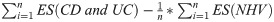
Inflammatory bowel disease molecular activity score classification of patient samples.(A) Shown are the scatterplots of the sum of gene set variation (GSVA) enrichment scores (ES) using all 58 upregulated signatures in Fig 2A common for Crohn’s disease (CD) and ulcerative colitis (UC) participant samples (GSE16879) using the following formula: I_MDS score = ∑i=1nES(CDandUC)−1n*∑i=1nES(NHV). Samples have been classified into normal healthy volunteer (NHV), clinical responders at baseline (R BL) or post-treatment (R PT) and clinical non-responders at baseline (NR BL) or post-treatment (NR PT). Pair-wise T-test statistics are listed in S5 Table. (B) and (C) show the I_MDS score outputs identifying clinical responders and non-responders before treatment with 100% specificity and 78.8% sensitivity (B, GSE16879) and confirmation in an independent dataset [37, 38, 39] with 87.5% specificity and 85.7% sensitivity.